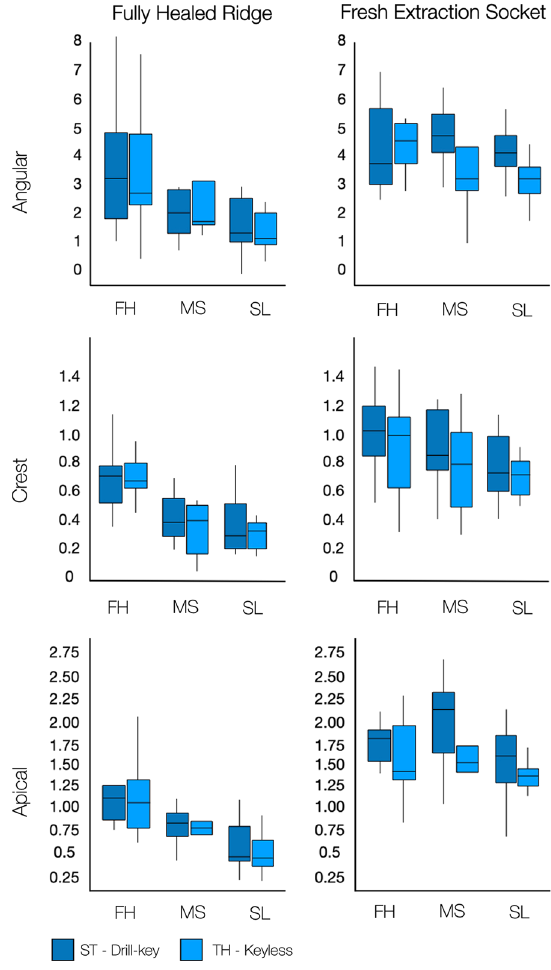
Fig. 4 Box plots demonstrating 3D implant deviations (angular, at the crest and apex) when a free‑hand technique, or sCAIS utilizing a manufacturer’s sleeve or sleeveless guide‑hole designs were used in alveolar ridges with different morphologies. FH free‑handed, MS manufacturer’s sleeve, SL sleeveless; ST: bone level 4.1 Straumann AG; TH: element MC